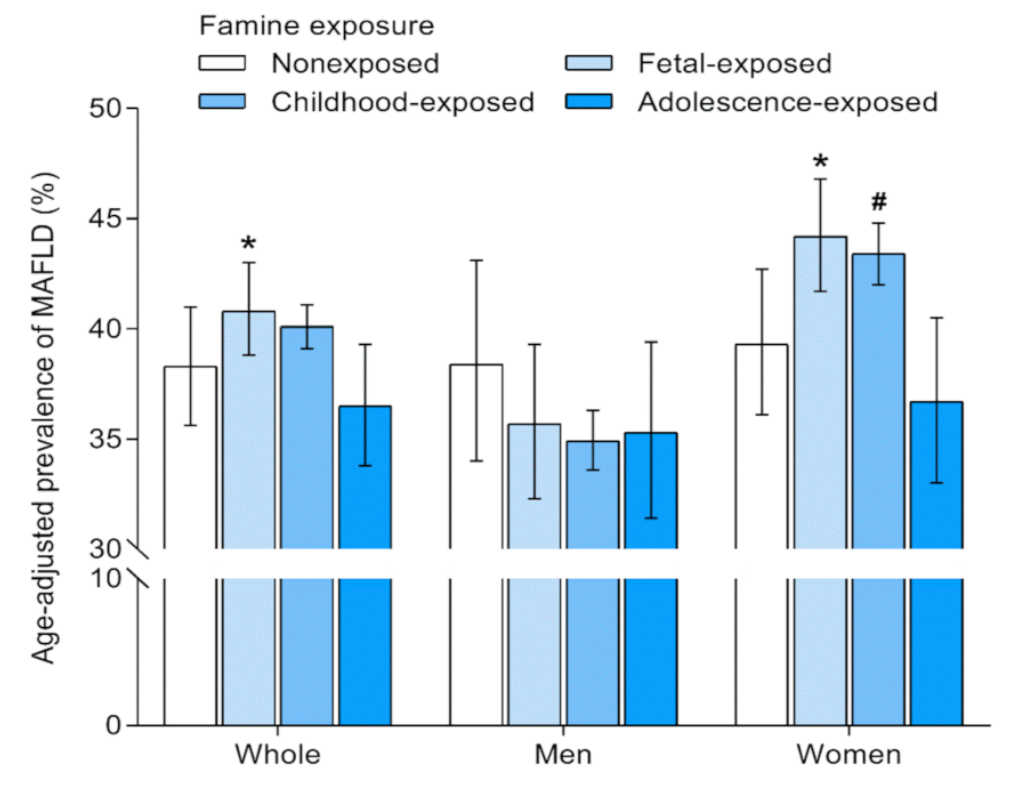
Figure 2. Age-adjusted prevalence of MAFLD according to famine exposure in early life. Prevalence rate was derived from logistic regression models. Error bars indicate 95% confidence intervals. MAFLD, metabolic associated fatty liver disease. * Compared with the unexposed, p -value < 0.05. # Compared with the unexposed, 0.05 < p -value <